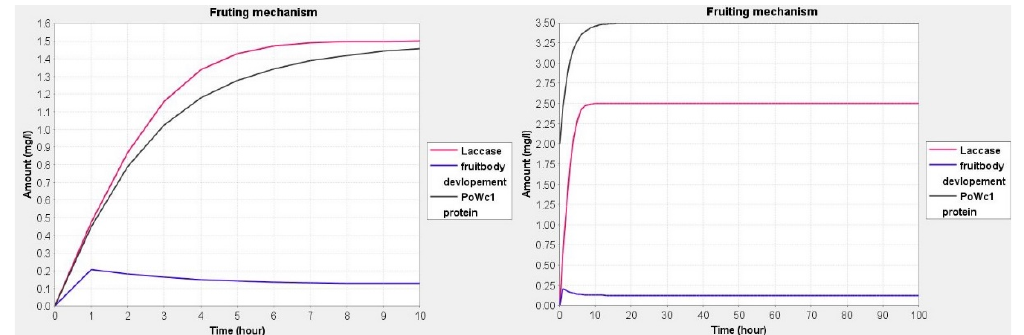
Figure 5. Dynamics of PoWC1 protein and Laccase with respect to fruit body development, the amount of PoWC1 protein was set at 0.0 and 2.0, respectively, while Laccase and fruit body devel- opment were set at 0.0.